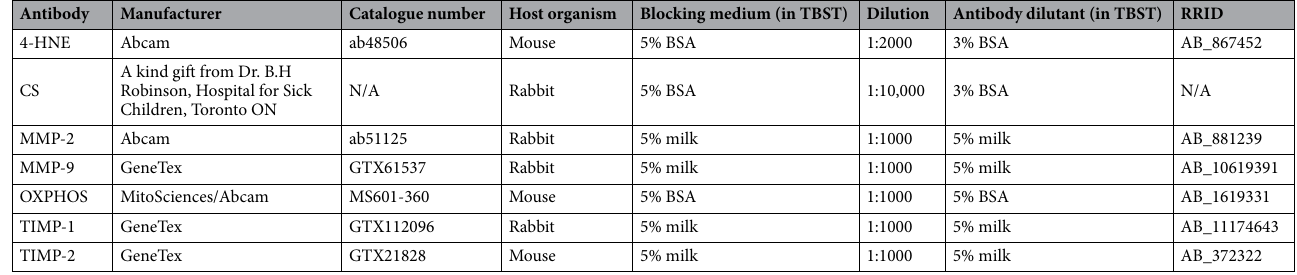
Table 2. Antibodies used for western